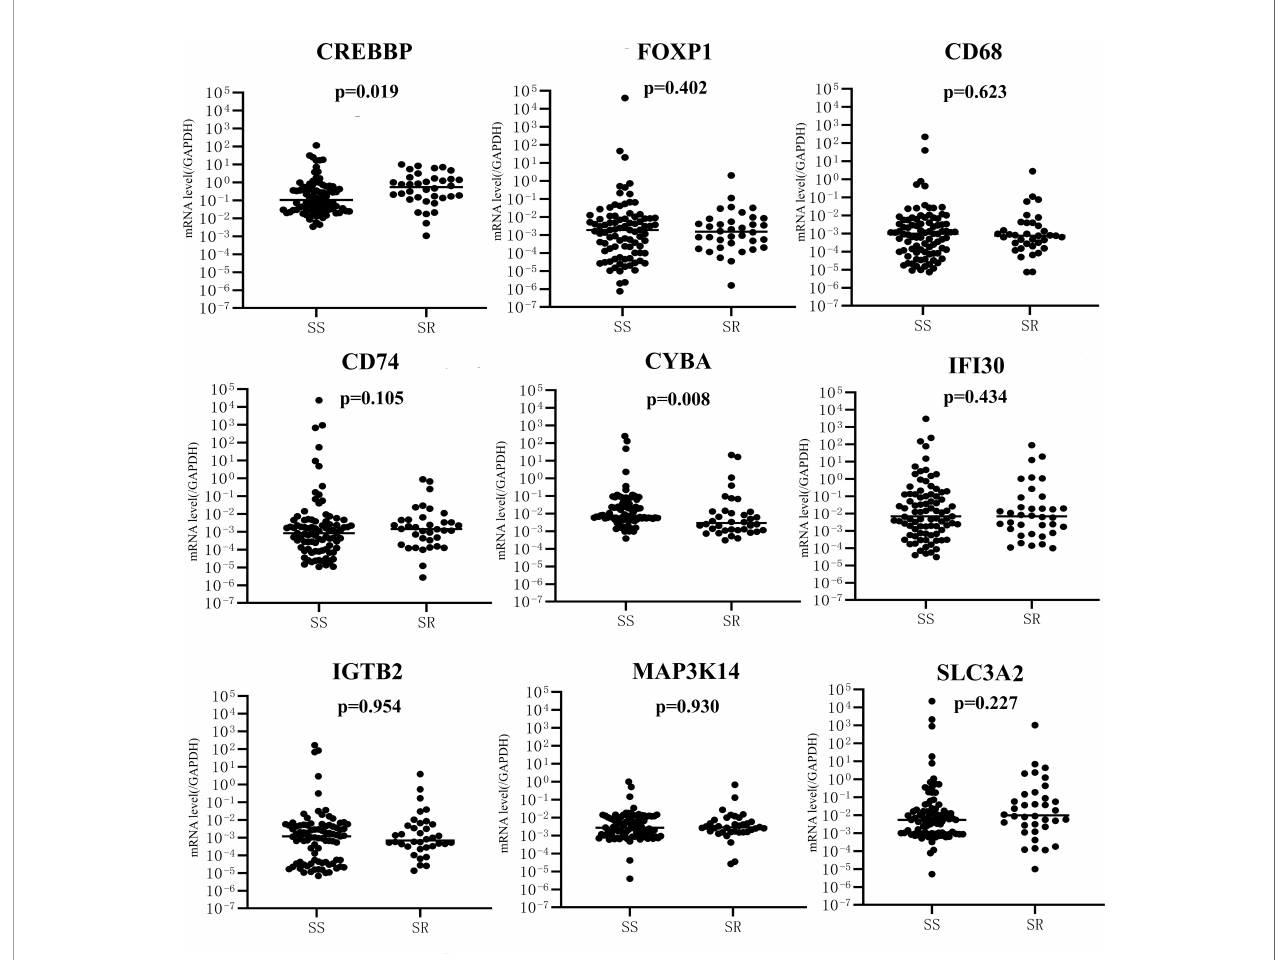
FIGURE 4 | mRNA expression of nine genes between SS ( n = 94) and SR ( n = 35) groups. SS, SSNS; SR, SRNS.